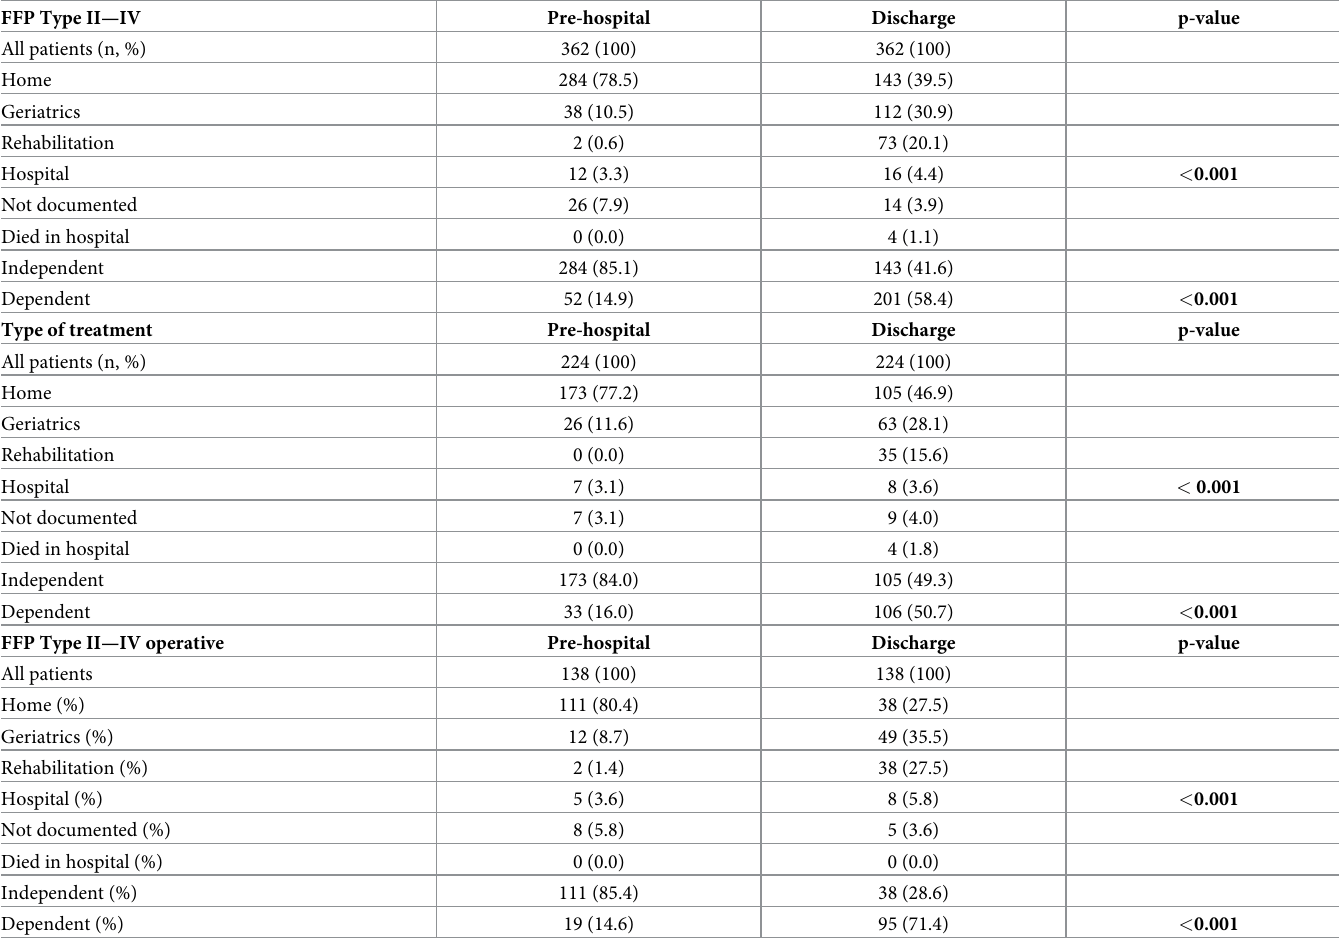
P-values below 0.05 are shown in